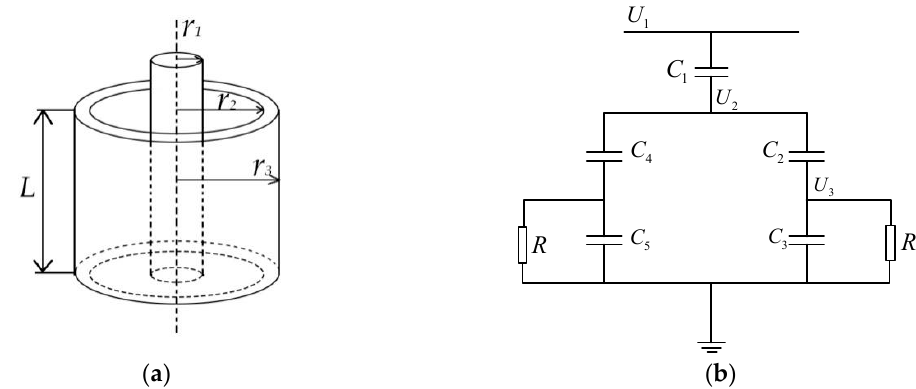
Figure 2. ( a ) The structure of coaxial capacitive and ( b ) the equivalent circuit model of voltage divider.